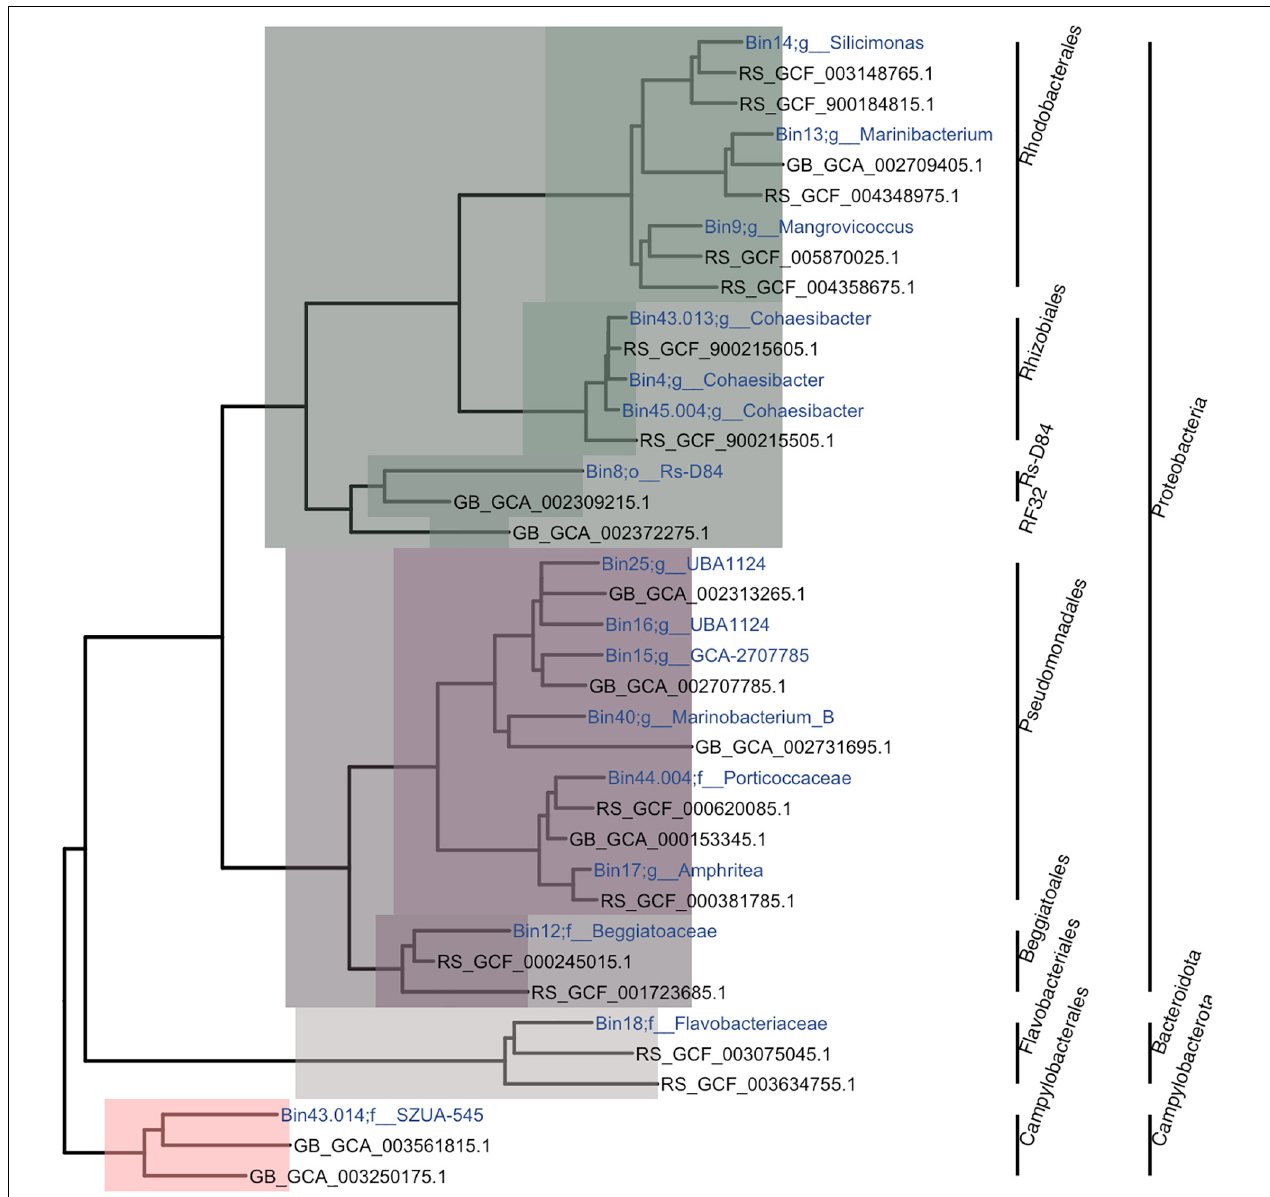
FIGURE 3 | Phylogenetic tree of metagenome-assembled genomes (MAGs). The tree is a subtree from the Genome Taxonomy Database Toolkit (GTDB-Tk). For each MAG, one sibling and one first cousin, if they existed, were randomly chosen to be plotted. The colors represent the classes Alphaproteobacteria (green), Gammaproteobacteria (purple), Flavobacteria (gray), and Campylobacterales (salmon). Within each class, the different color tones represent different clades and bacterial orders. The name of each MAG was assigned based on bin number and the lowest taxonomic assignment designated.